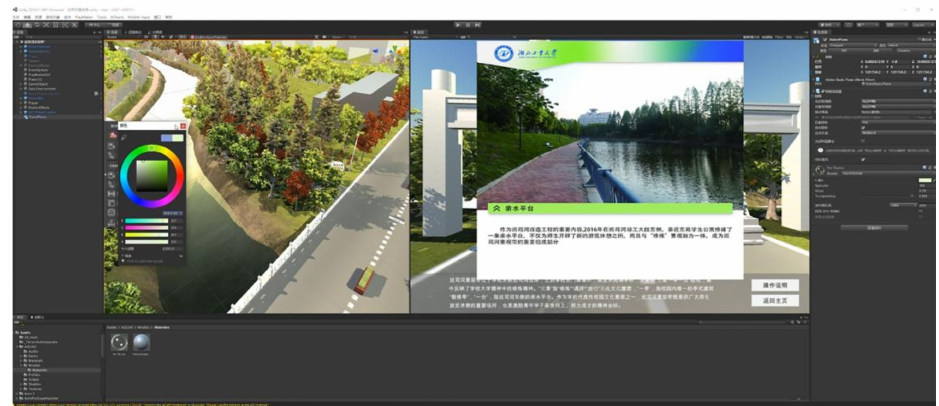
Figure 10. Unity3D implementation of scene manipulation.